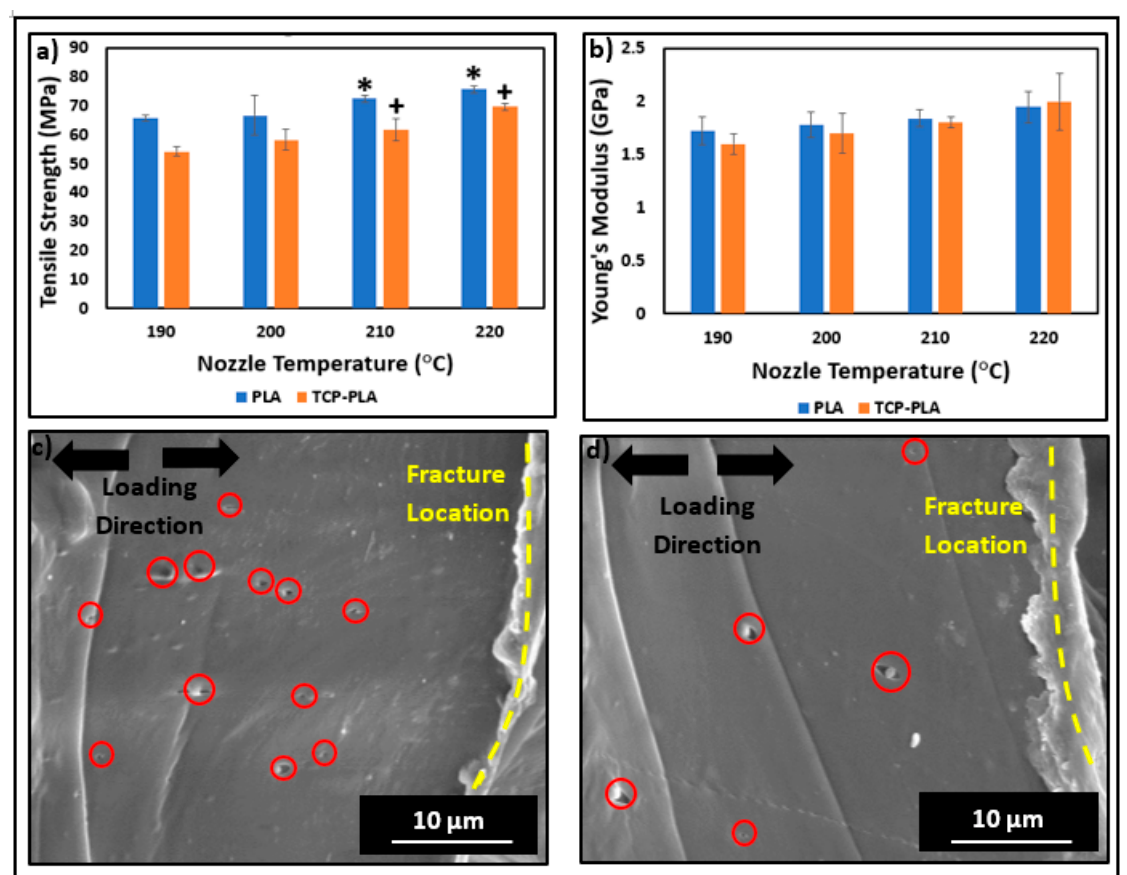
Figure 9. Second, the voids generated by the delamination of TCP particles from the PLA matrix, shown in Figure 11c,d.